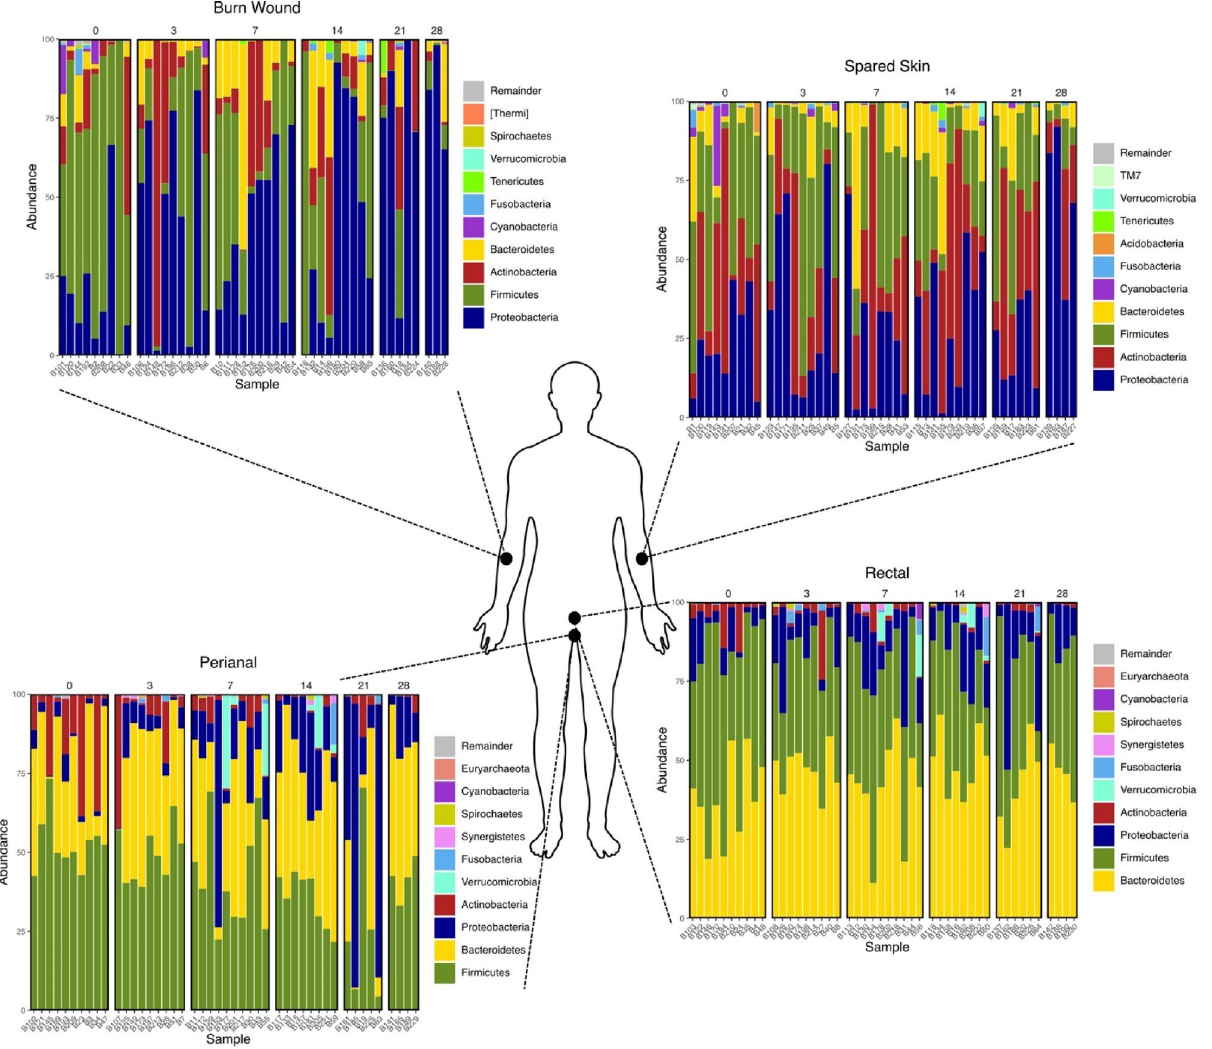
Figure 2. Burn patient taxonomic summary. Summary of taxonomic relative abundance consisting of the top 10 phyla sequenced from samples collected at four collection locations (burn wound, spared skin, perianal, and rectal) on the burn patient cohort displayed by collection day. The numbers at the top of each panel represent the collection timepoint (“0” represents samples collected on day 0, etc.). Phyla are listed descending from least to most abundant. This figure was generated using the software Inkscape and graphical taxonomic output from